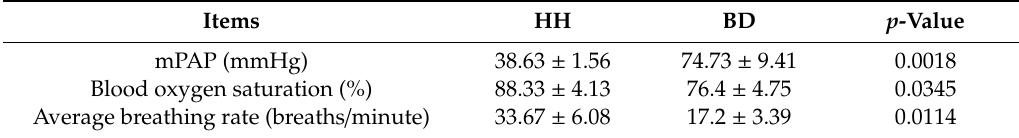
Table 1. Mean pulmonary arterial pressure, blood oxygen saturation and average breathing rate of Holstein heifers. Items